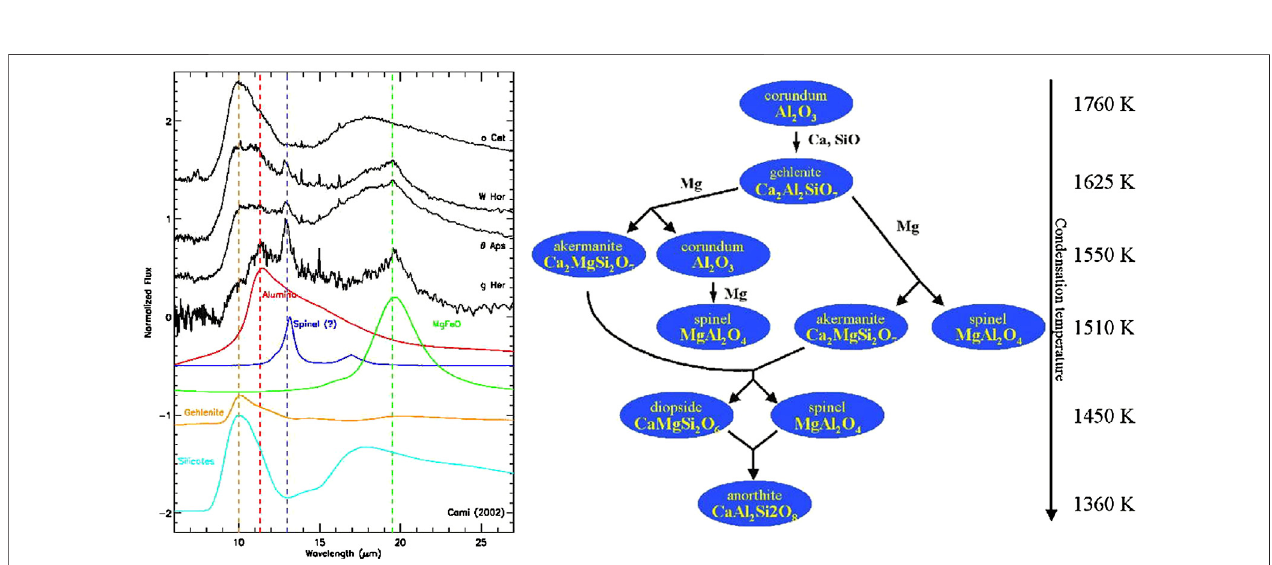
FIGURE2| Left:AselectionofISOSWSspectraofAGBstarsillustratingtherichspectraldiversityofthecircumstellardustcompounds(Cami2001).Asthebottom traces of laboratory results demonstrate, these spectra show evidence for Aluminum oxides, spinel magnesium oxides, and amorphous (magnesium) silicates. Right: Thecondensationsequenceofoxidesandcalcium-aluminum-silicates.Thebulkofthedustisthoughttocondenseoutasmagnesiumsilicatesat1250 Kontopofthese high temperature compounds. The objects in the left panel are thought to represent different stages in this dust condensation process “ preserved ” by freeze out. See text for more